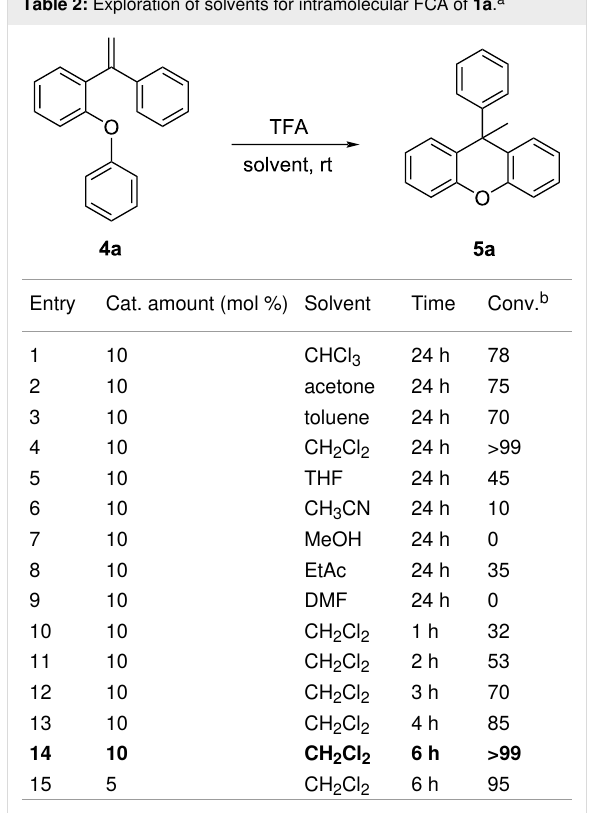
Table 2: Exploration of solvents for intramolecular FCA of 1a .